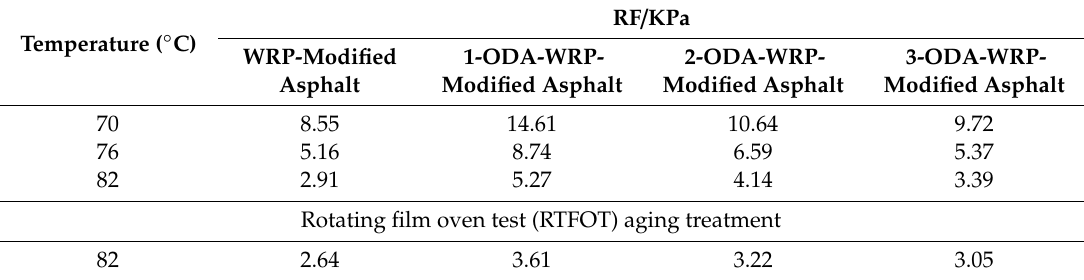
Table 2. Rutting factor (RF) value of di ff erent original and short-term aged asphalts at di ff erent